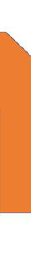
Figure 8. RAMI component.